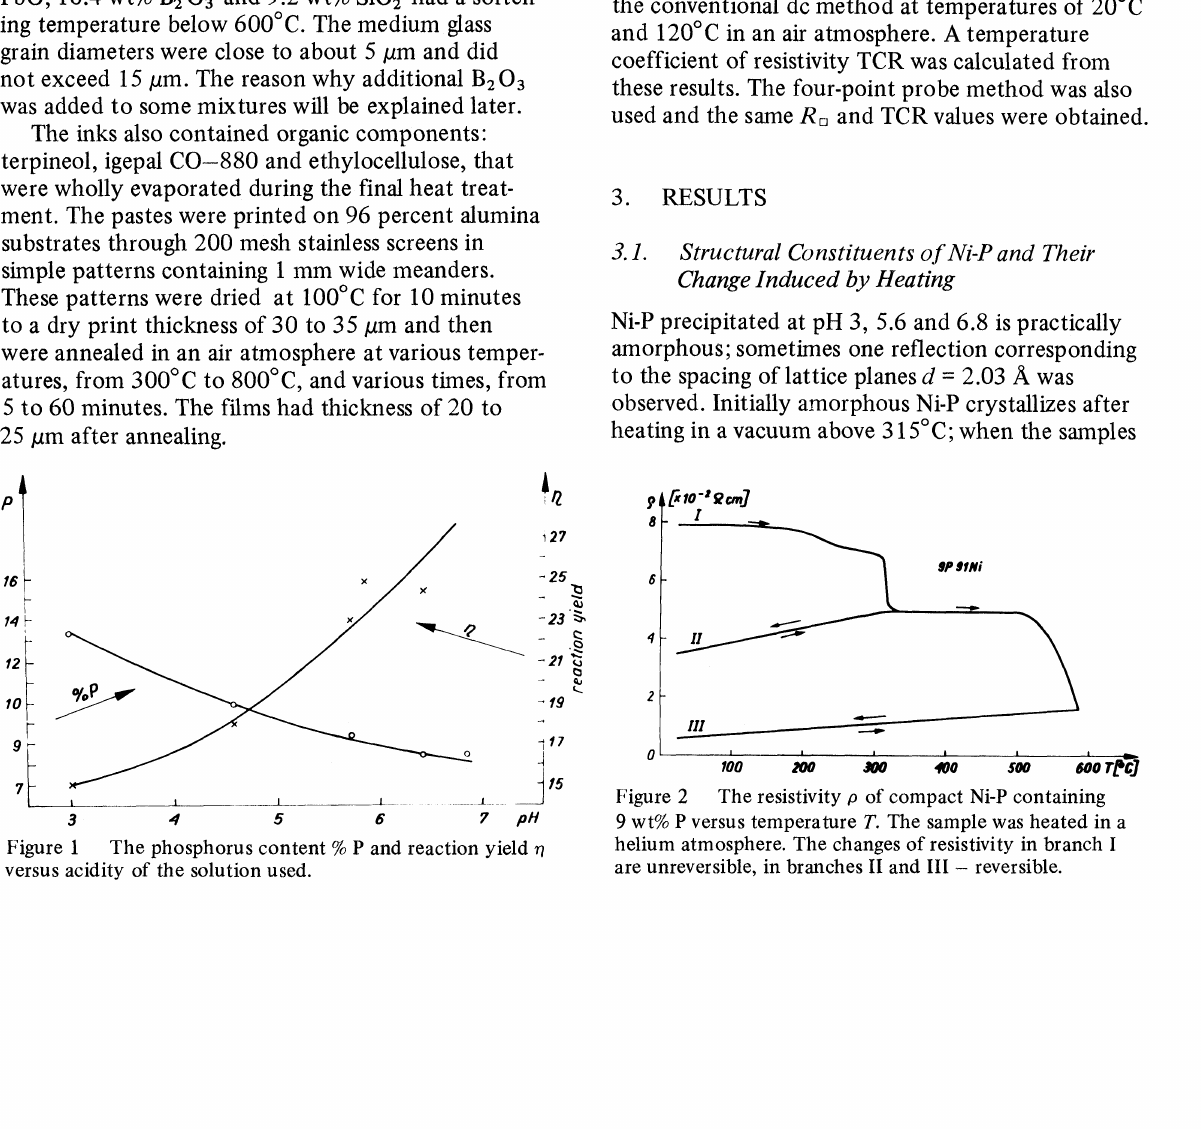
The resistivity o of compact Ni-P containing 9 wt% P versus temperature T. The sample was heated in a helium atmosphere. The changes of resistivity in branch are unreversible, in branches II and III